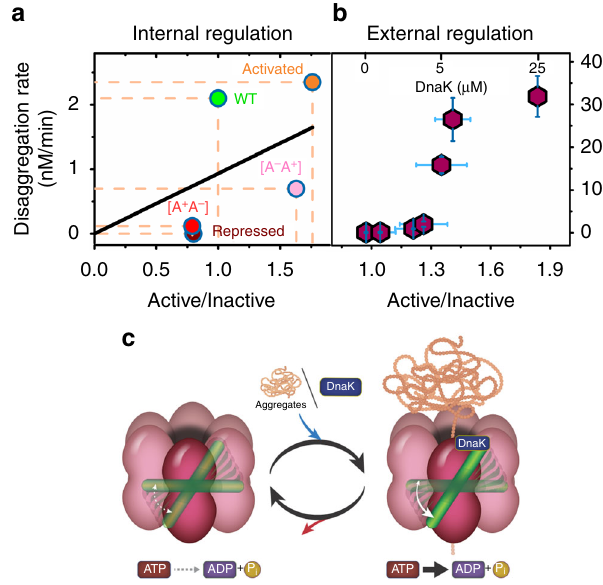
Fig. 6 Tuning of the M-domain population ratio controls ClpB disaggregation rate. a Internal regulation: a map of the disaggregation rate vs. the active/inactive population ratio, obtained with different ClpB mutants, displays a high correlation coef fi cient of 0.94 ± 0.3, based on a linear fi t to the data points (black line). b External regulation: disaggregation activity increases sigmoidally with the population ratio, here controlled by the concentration of DnaK. c Schematic of the paradigm for the operation of the M domain as a tunable switch that determines the level of activity of the machine. The M domain is in a dynamic equilibrium between the active and inactive states, rather than statically populating one of them. In the presence of ATP only (left) the ratio between the states is ~1, facilitating DnaK approach and binding. The addition of DnaK or aggregates (right) changes the ratio between the states by stabilizing the active state in a dose-response manner, which in turn tunes the machine ’ s activity level. Error bars represent standard errors of the